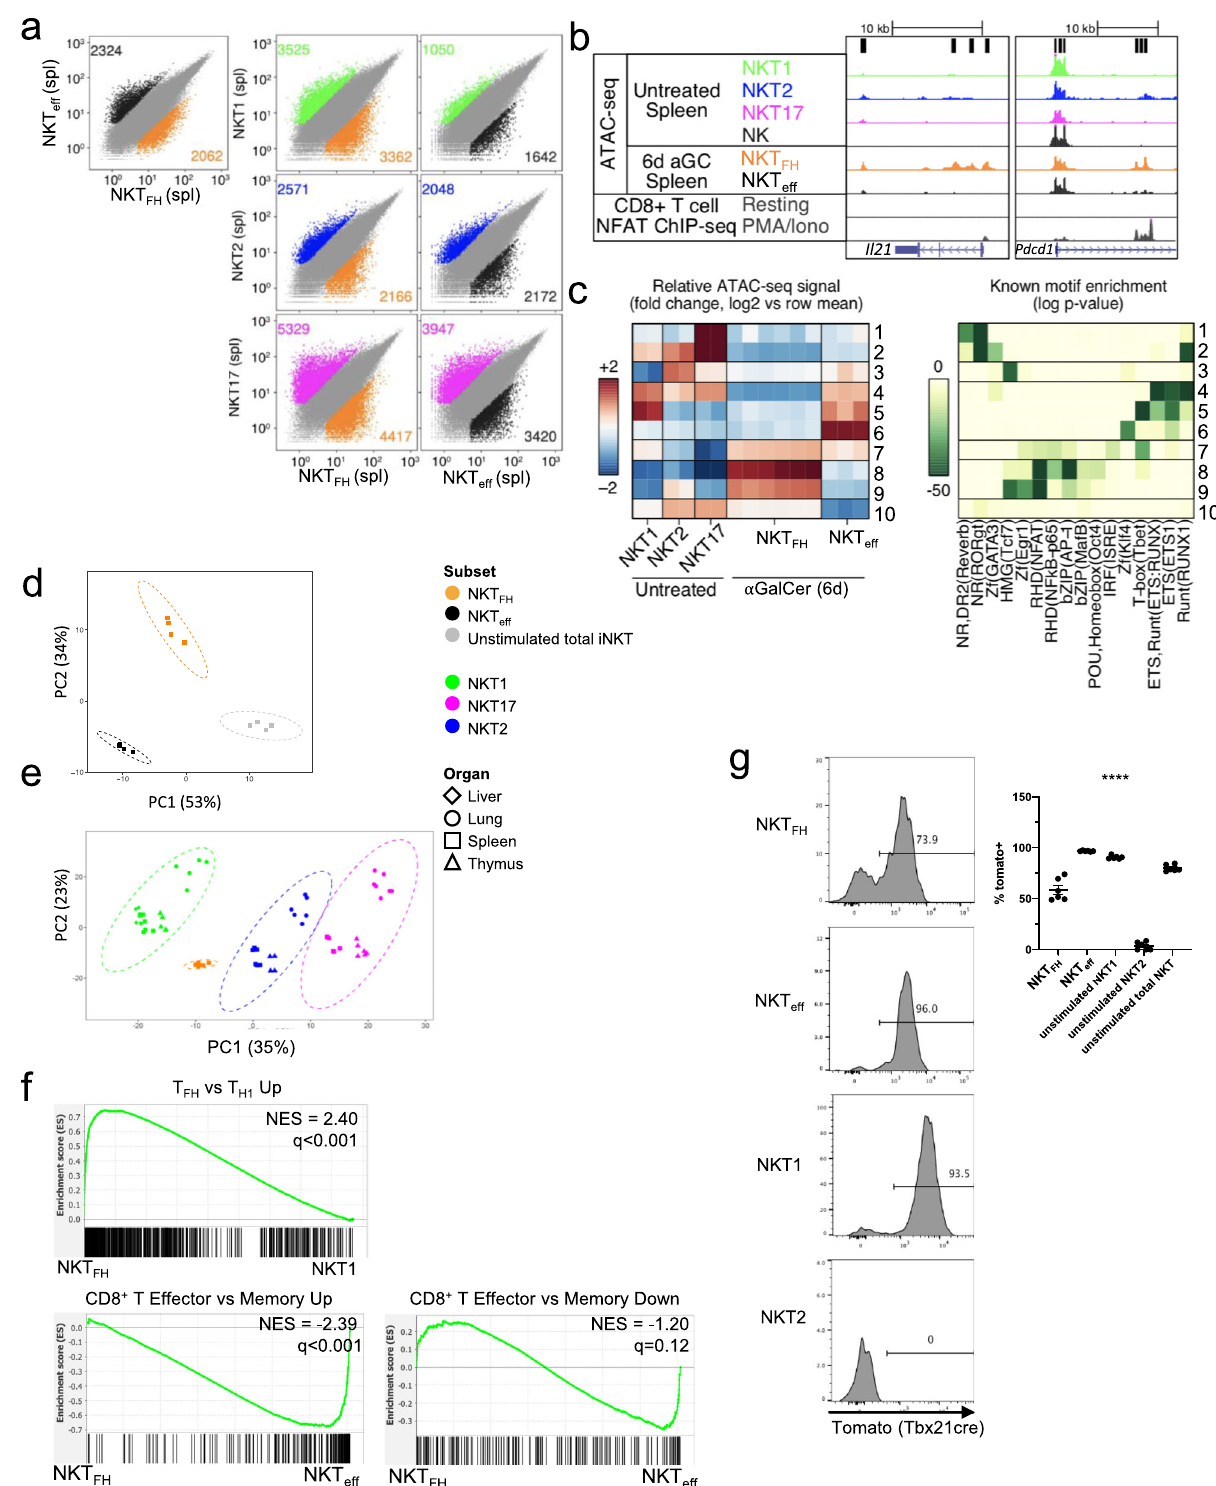
more similar expression pro fi le to T FH , whereas, not surpris- ingly, NKT1 cells were similar to T H 1 (Supplementary Fig. 4d). Similarities between NKT FH and T FH also were revealed by GSEA analysis (Fig. 5f, top panel). GSEA of NKT FH compared to NKT eff revealed an enrichment for CD8 + T cell effector- related genes in NKT eff (Fig. 5f, bottom, left, and right panels). Neither antigen-experienced subset was signi fi cantly enriched for memory cell-related